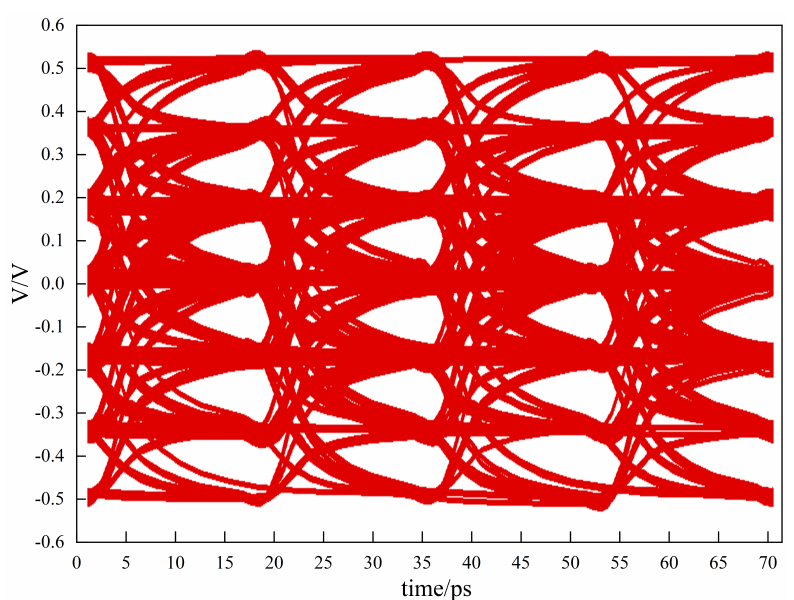
Figure 18. The layout post-simulation of the